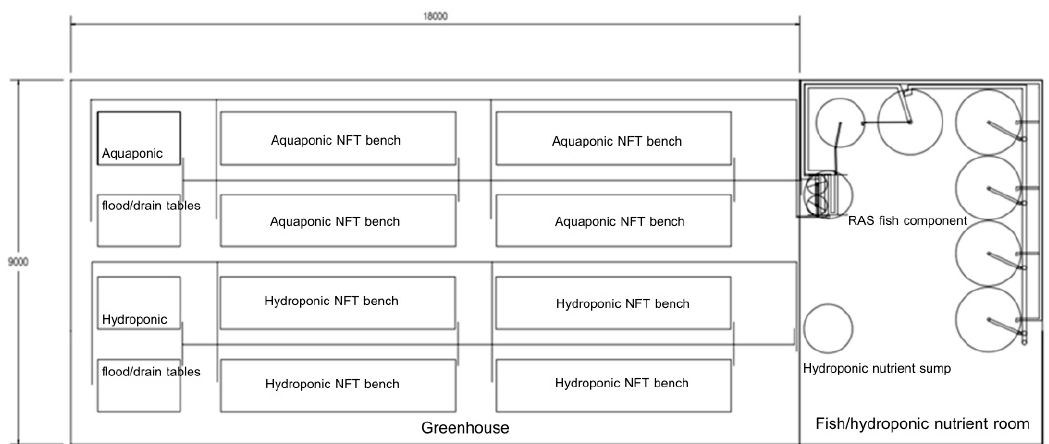
Figure 1. Schematic representation of the aquaponic and hydroponic experimental set-up (aquaponic plant component at the top, hydroponic plant component at the bottom).